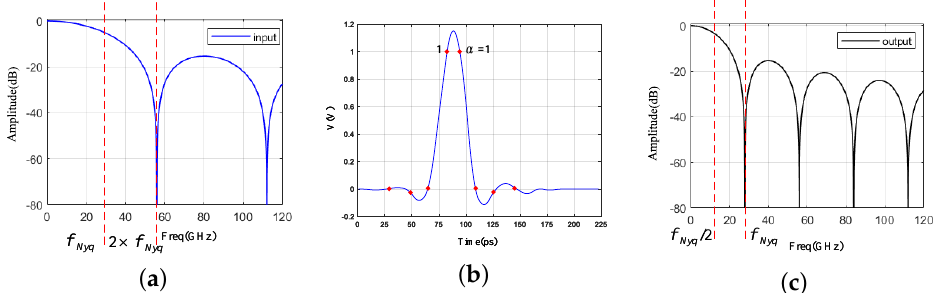
Figure 2. ( a ) 112 Gb/s PAM4 power spectral density (PSD) at TX. ( b ) Shape total channel response to 1 + z − 1 . ( c ) 112 Gb/s DB-PAM4 Power spectral density (PSD) at RX.